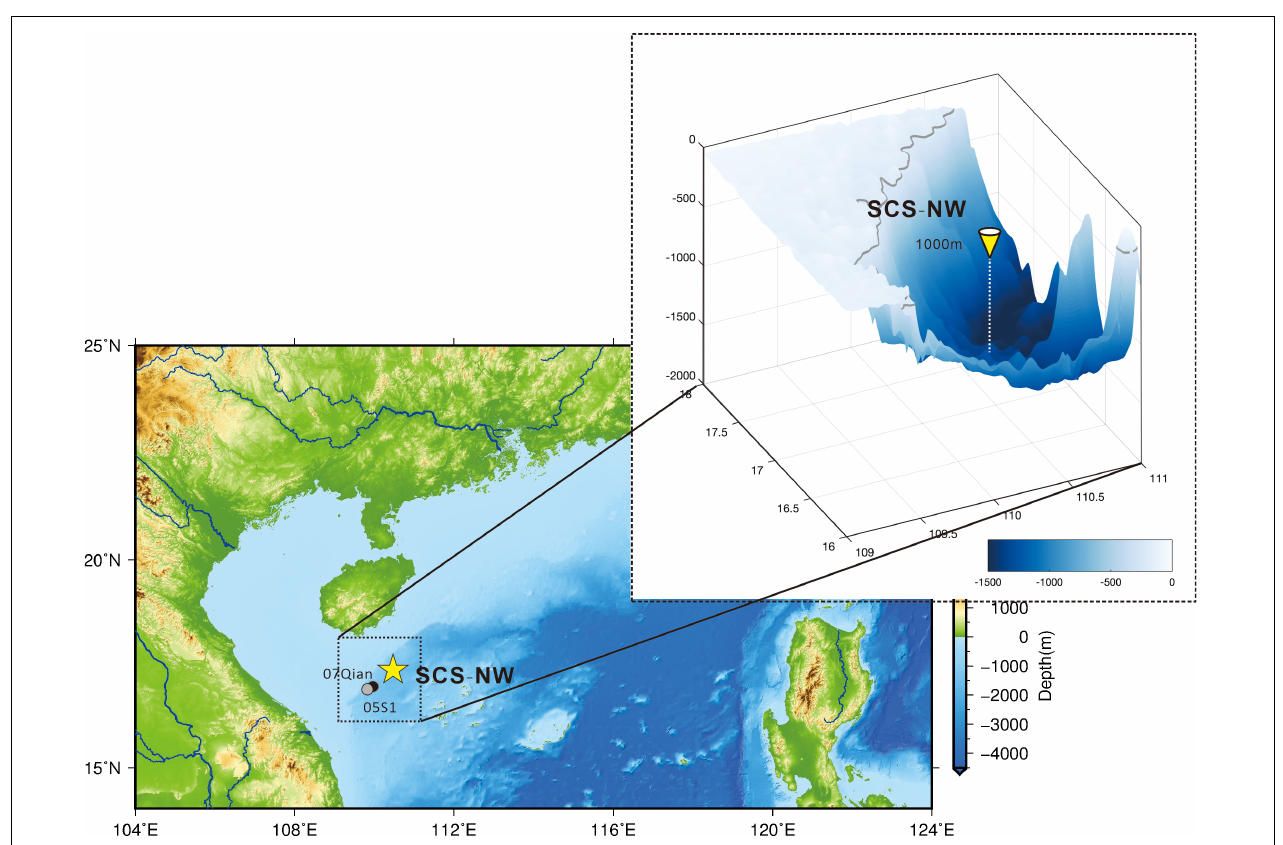
FIGURE 1 | Site location of the sediment trap station and the sketch diagram of the sediment trap mooring in the northwestern